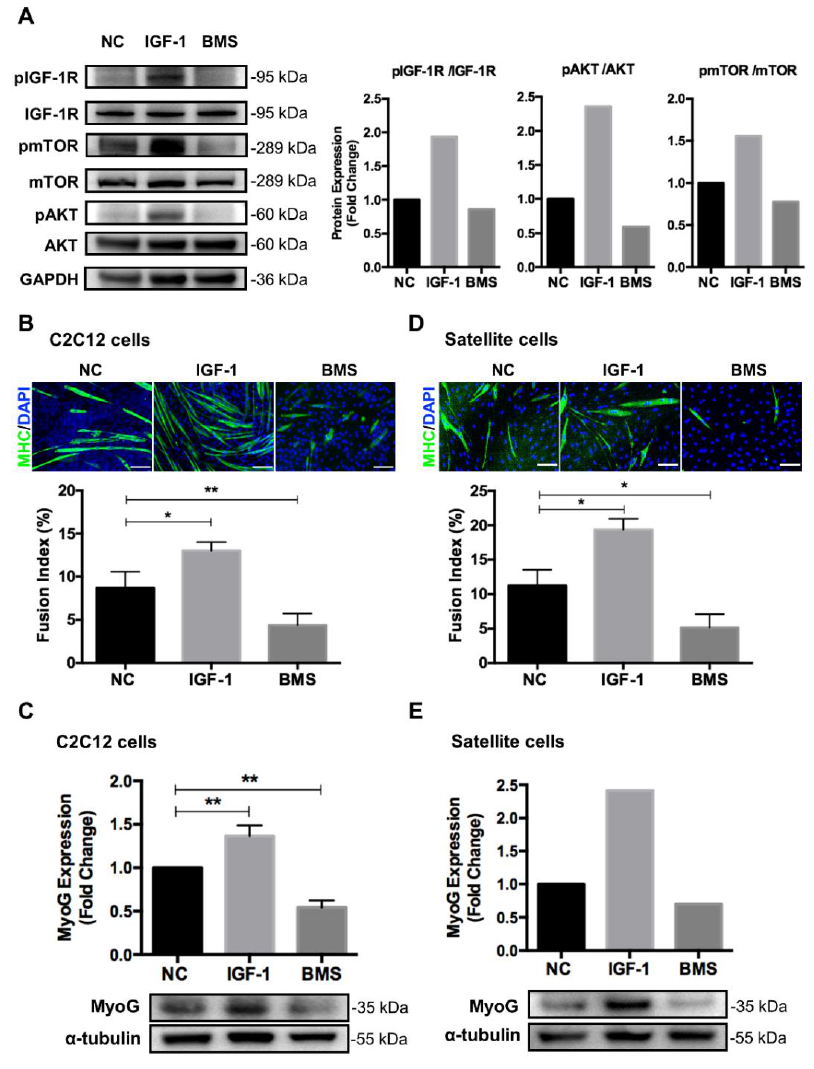
Figure 1. IGF-1 signaling regulates myoblast differentiation. C2C12 myoblasts or satellite cells were cultured in the DM supplemented with 0.1% DMSO, 10ng/mL IGF-1, or 200nM BMS for 5 days. ( A ) Representative immunoblots of IGF-1R, pIGF-1R, mTOR, pmTOR, AKT, pAKT, or GAPDH in C2C12 cells treated with 0.1% DMSO (NC), 10 ng/mL IGF-1, or 200 nM BMS. ( B )